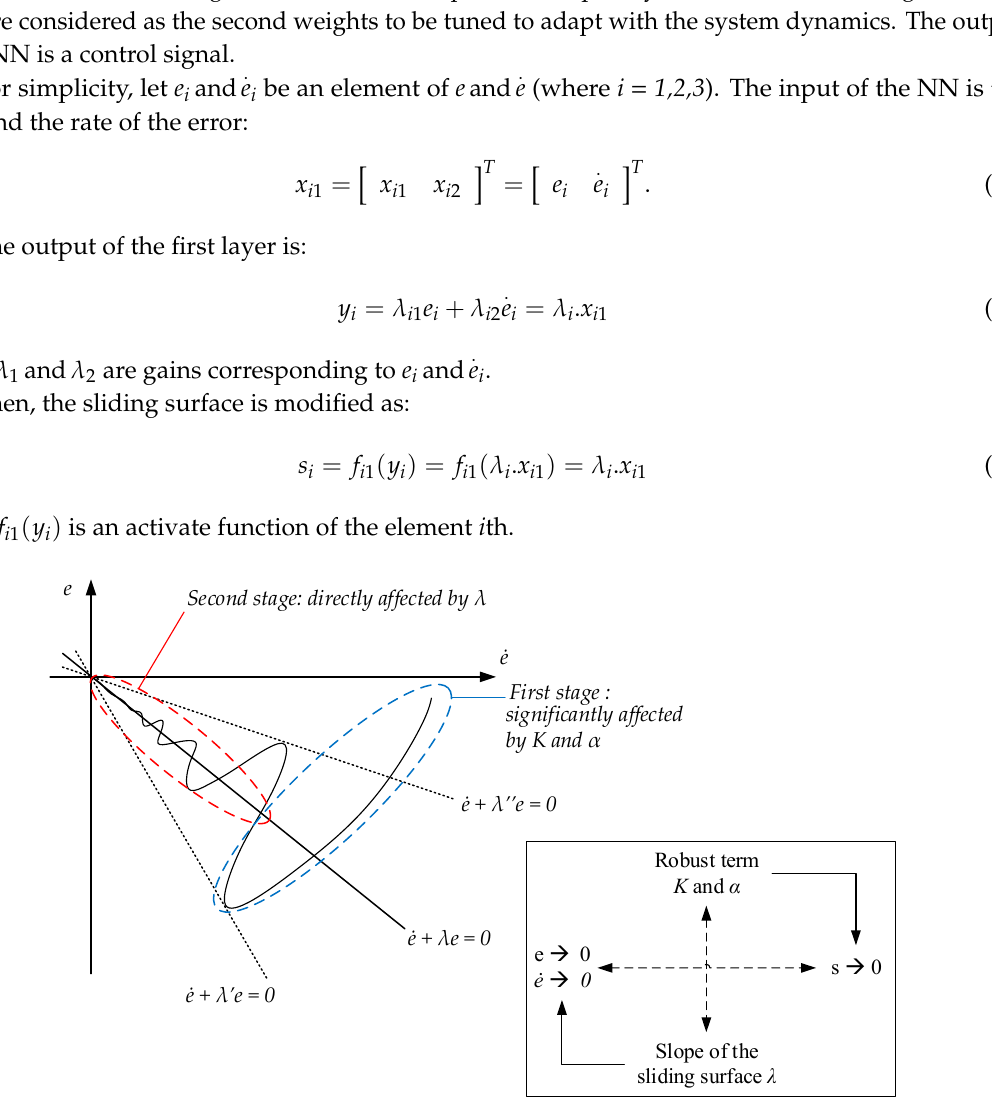
Figure 3. The motion of the state trajectory of the sliding mode control in which the two stages and the two terms affecting the convergence rate of the state error are considered. The sub-figure shows the correlation between the robust term K and α with the slope of the sliding surface λ .